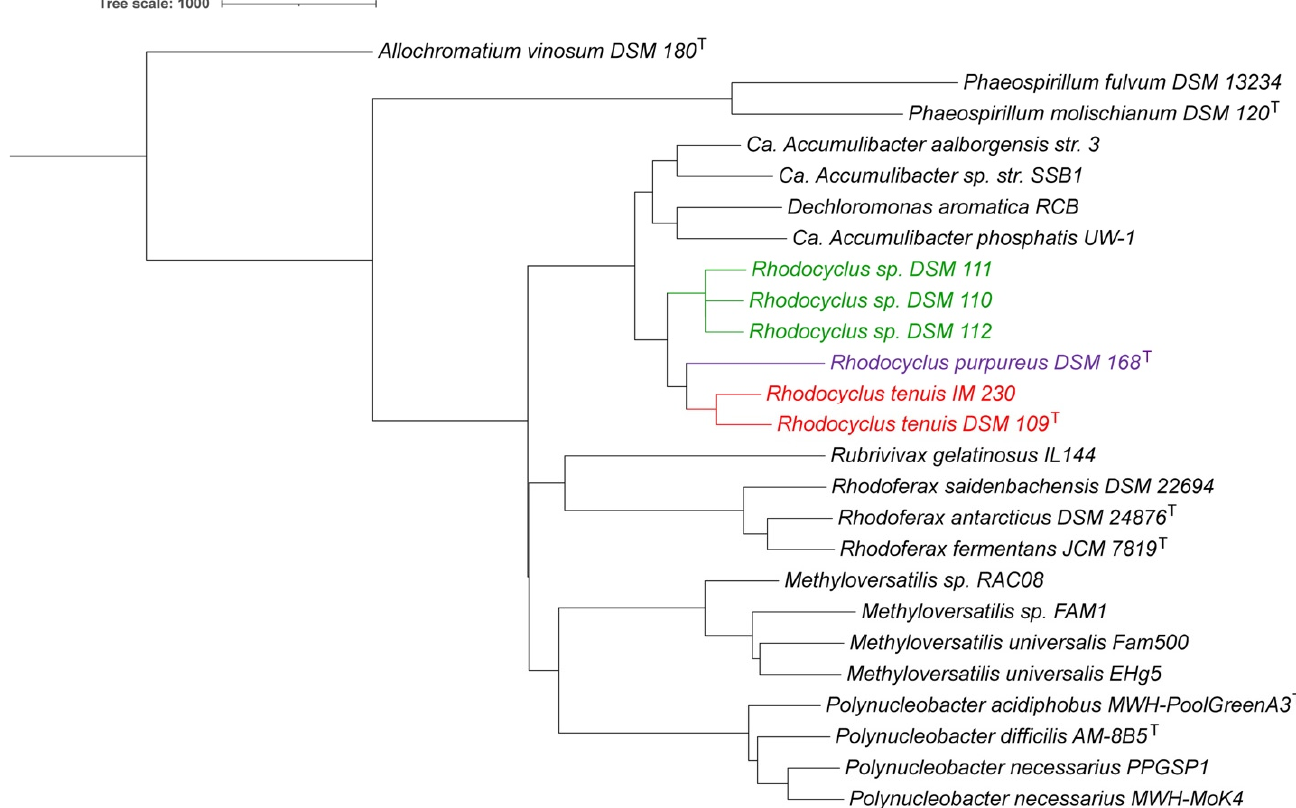
Figure 3. 16S rRNA phylogenetic tree for Rhodocyclus and related species. The phylogenetic tree was calculated by the neighbor ‐ joining (NJ) method [36] within Jalview [37]. iTOL was used to draw the phylogenetic trees expressed in the Newick phylogenetic tree format [33]. Allochromatium vinosum DSM 180 T was added as an outgroup. Rhodocyclus species were color ‐ coded the same as in Figure 1.